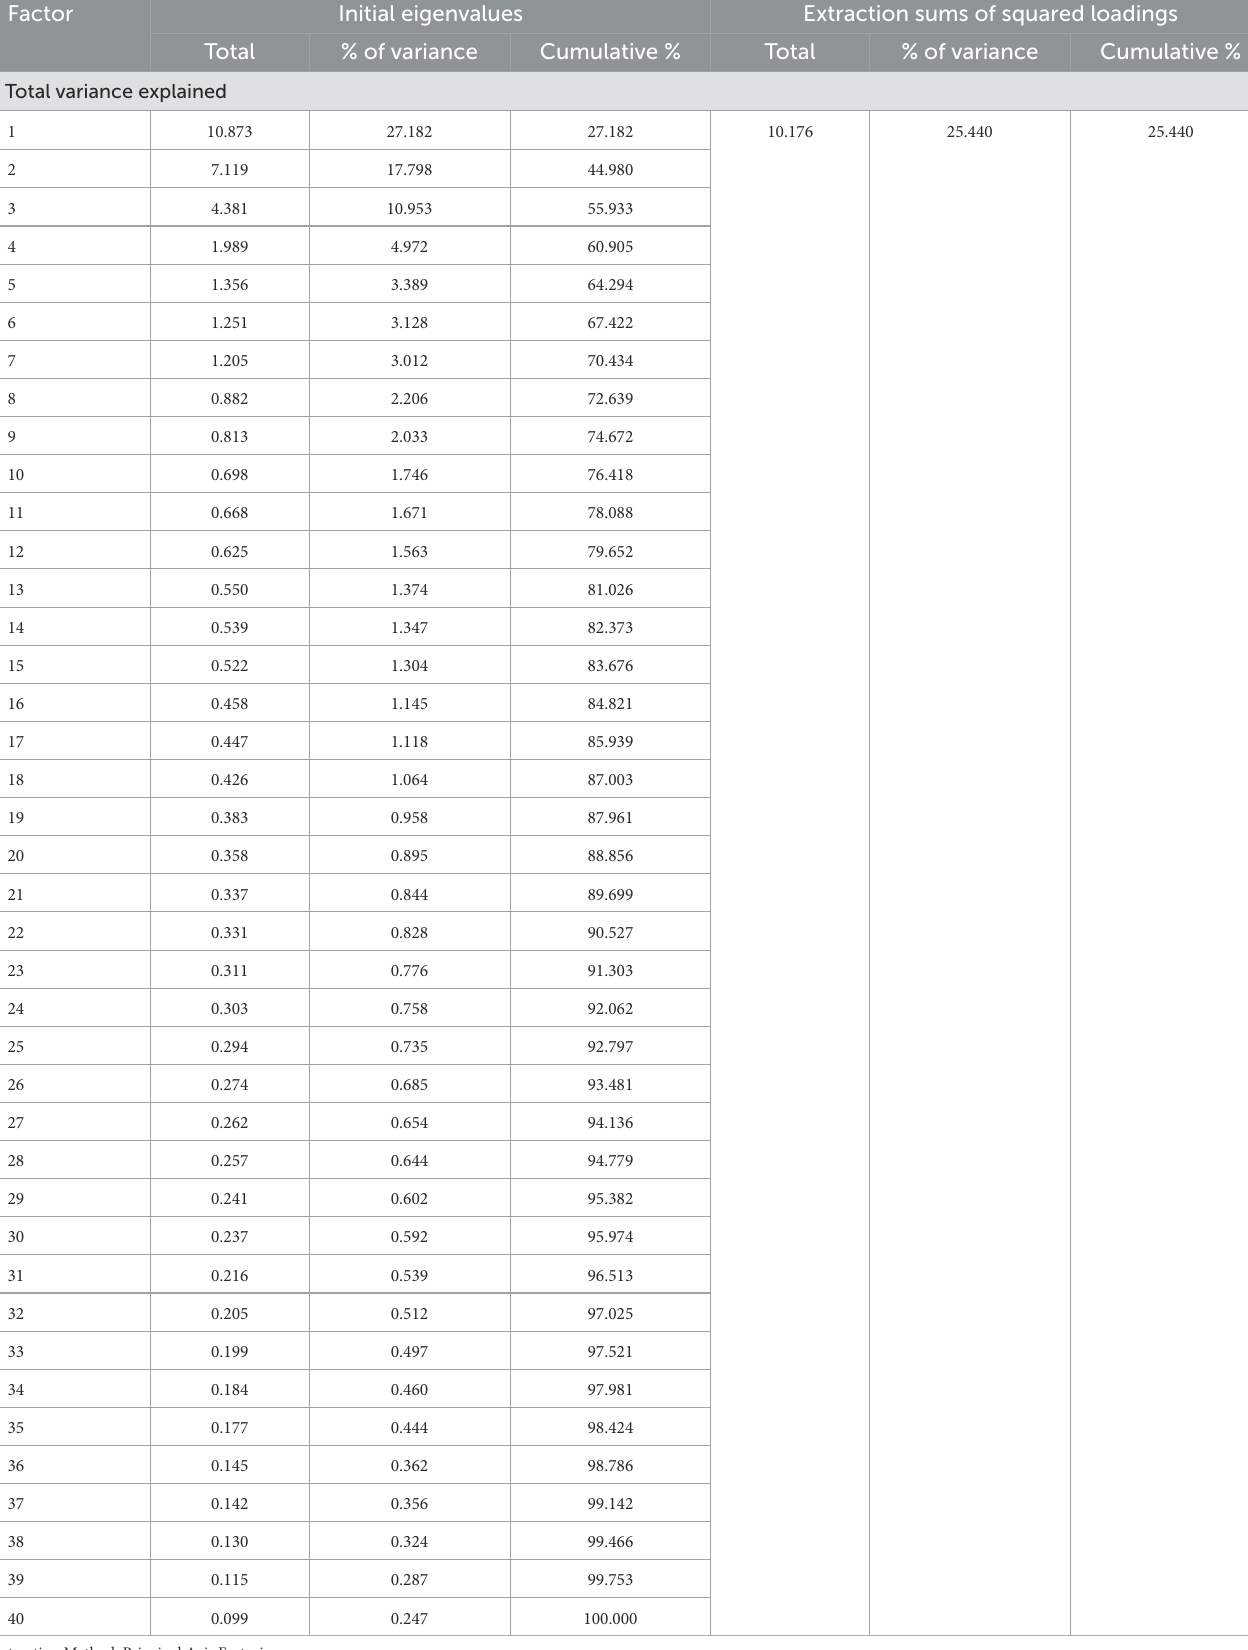
TABLE 2 Common method